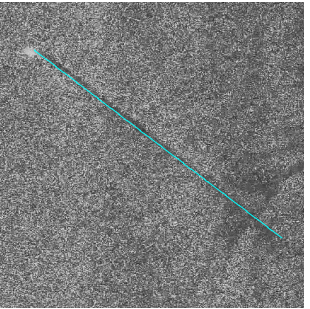
Figure 11. Wake detection results by local Radon transform.